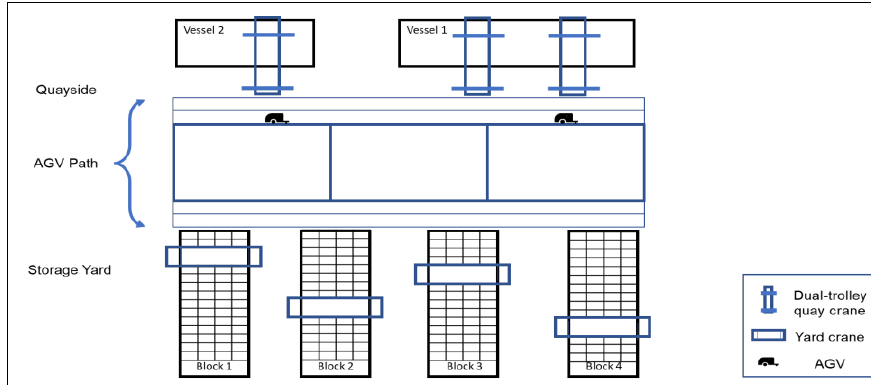
Figure 2. A typical layout of an ACT .